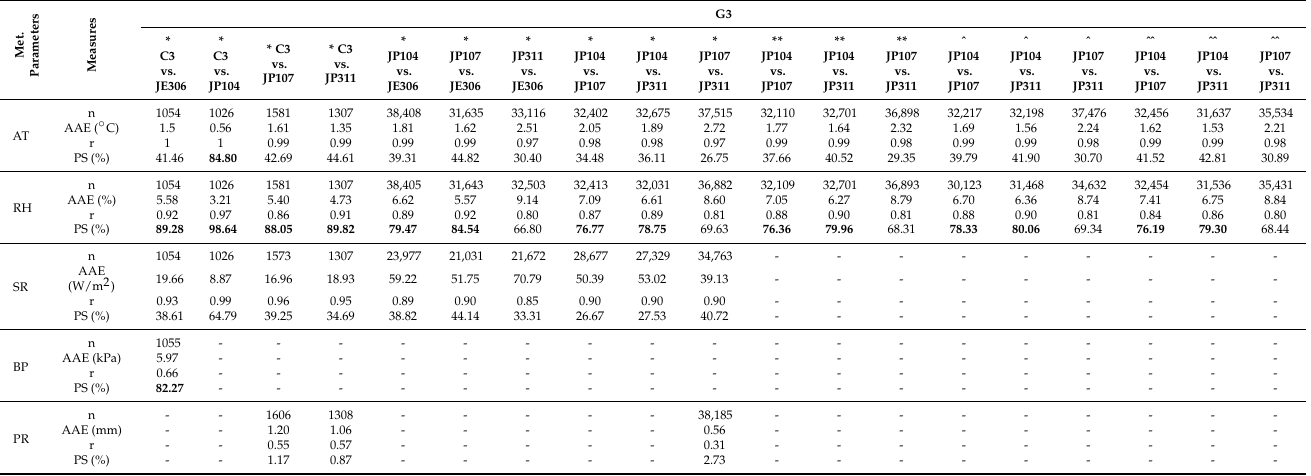
Table 3. The analysis of similarity and relations among the meteorological parameters for the G3 group, measured at 2 m height. The sign ‘-’means the measurements were unavailable for comparison and highlighted bold values mean strong PS with ≥